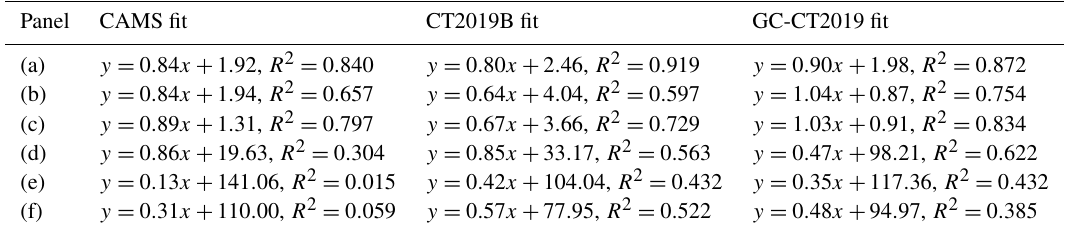
Table 2. Linear regression equations and correlation coefficients for the correlations, presented in Fig. 2, of model-derived versus observed SCA and HDD at three spatial scales for five ground sites.